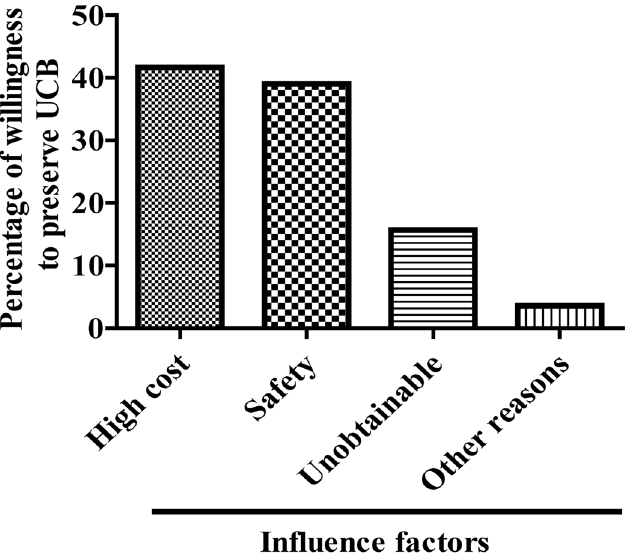
Fig 4. The primary factors influencing willingness to preserve